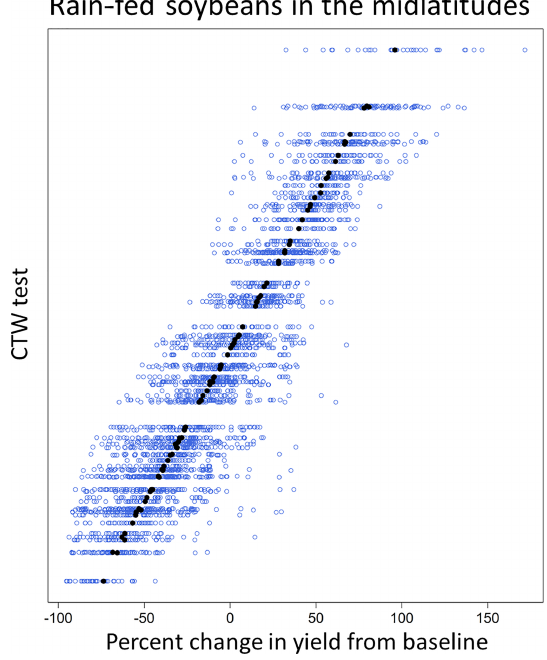
Figure 3. A plot of the percent yield change at each rain-fed soy- beans in the midlatitudes site (blue points) for each CTW test (each horizontal line of points is a different test). The black dot for each test represents the mean response across the sites for that